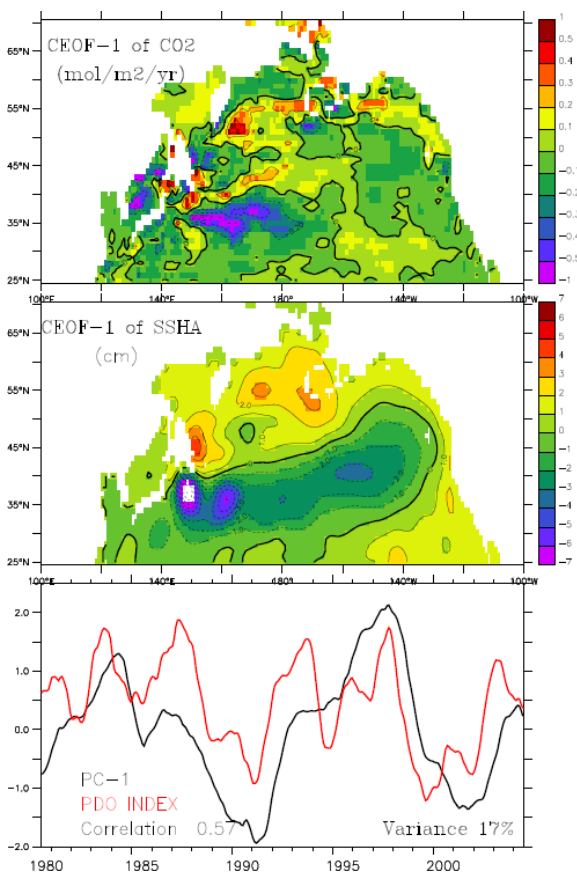
Figure 11: Same as Figure 9, but for CEOFs of CO 2 flux and SSH anomalies. 3 Fig. 11. Same as Fig. 9, but for CEOFs of CO 2 flux and SSH 4 anomalies.